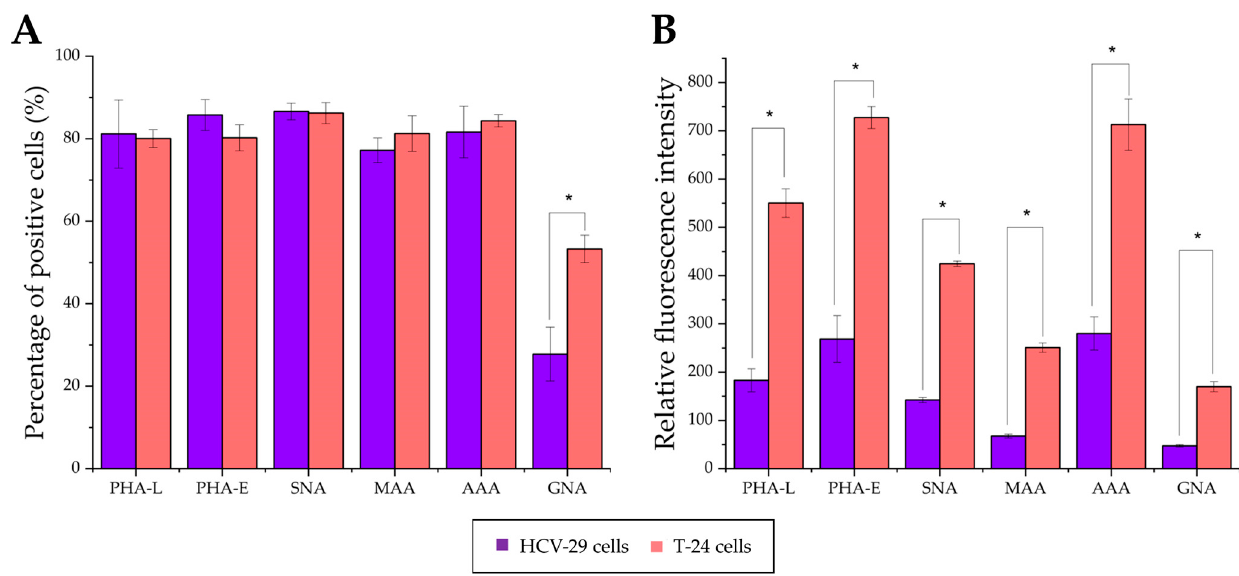
Figure 10. Flow cytometry analysis of surface glycosylation of HCV-29 and T-24 cells grown in control conditions. ( A ). Diagram showing the percentage of positive cells in each staining. ( B ). Diagram showing the relative fluorescence intensity (RFI) for each staining. *—denotes statistically significant differences.